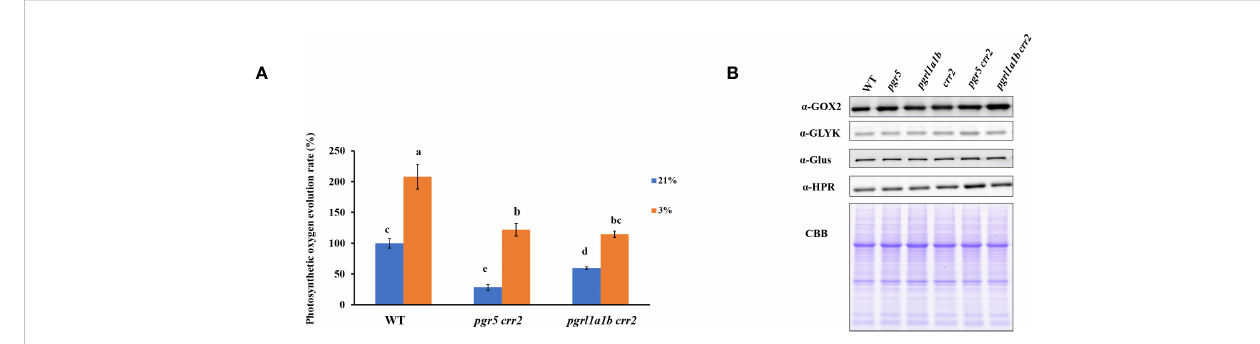
FIGURE 4 Comparison of photosynthetic oxygen evolution rate and accumulation of key proteins involved in the photorespiratory pathway among the CET mutants and wild type (WT) grown under low light conditions. (A) The photosynthetic oxygen evolution rates in CET mutants and WT are under 3% or 21% O 2 . The photosynthetic oxygen evolution rate of WT under 21% was 100% from the value of 5.30 m mol O 2 gFW − 1 h − 1 . (B) Immunoblotting was performed using antibodies against the GOX2, GLYK, Glus, and HPR in 10-day-old leaves. In the lower panel, a replicate gel stained with Coomassie brilliant blue (CBB) is shown as the loading control. Plants used for these experiments were cultured at a light intensity of 60 m mol m − 2 s − 1 at 22°C for 10